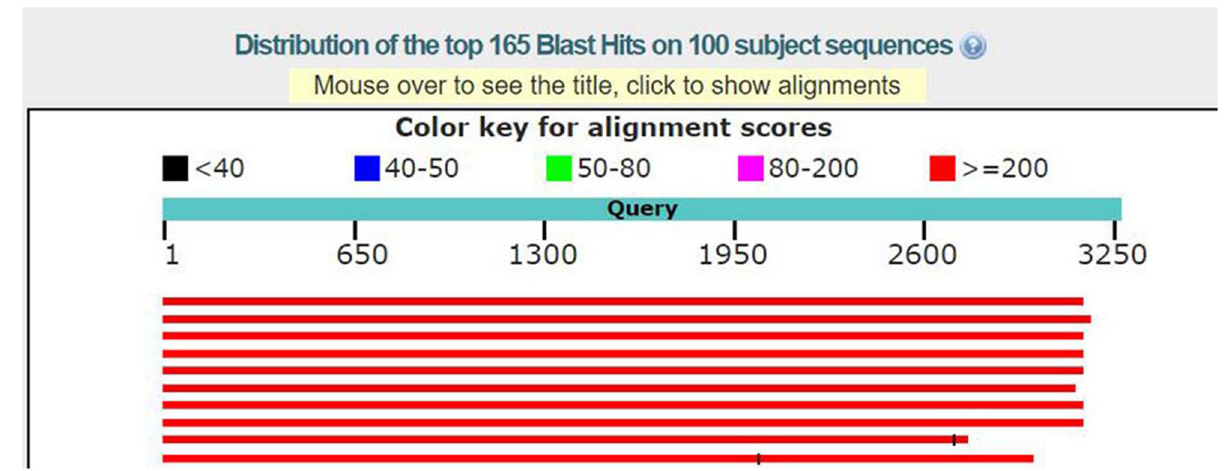
Fig 6. Graphic summary of the sequence alignment result of the suspected gene fragment 21-21000-24250. (a) Similarity color diagram, in which the similarity is arranged from high to low: red, purple, green, blue, black. (b) The suspected gene fragment has the highest degree of similarity and the best matching degree to the first gene sequence.